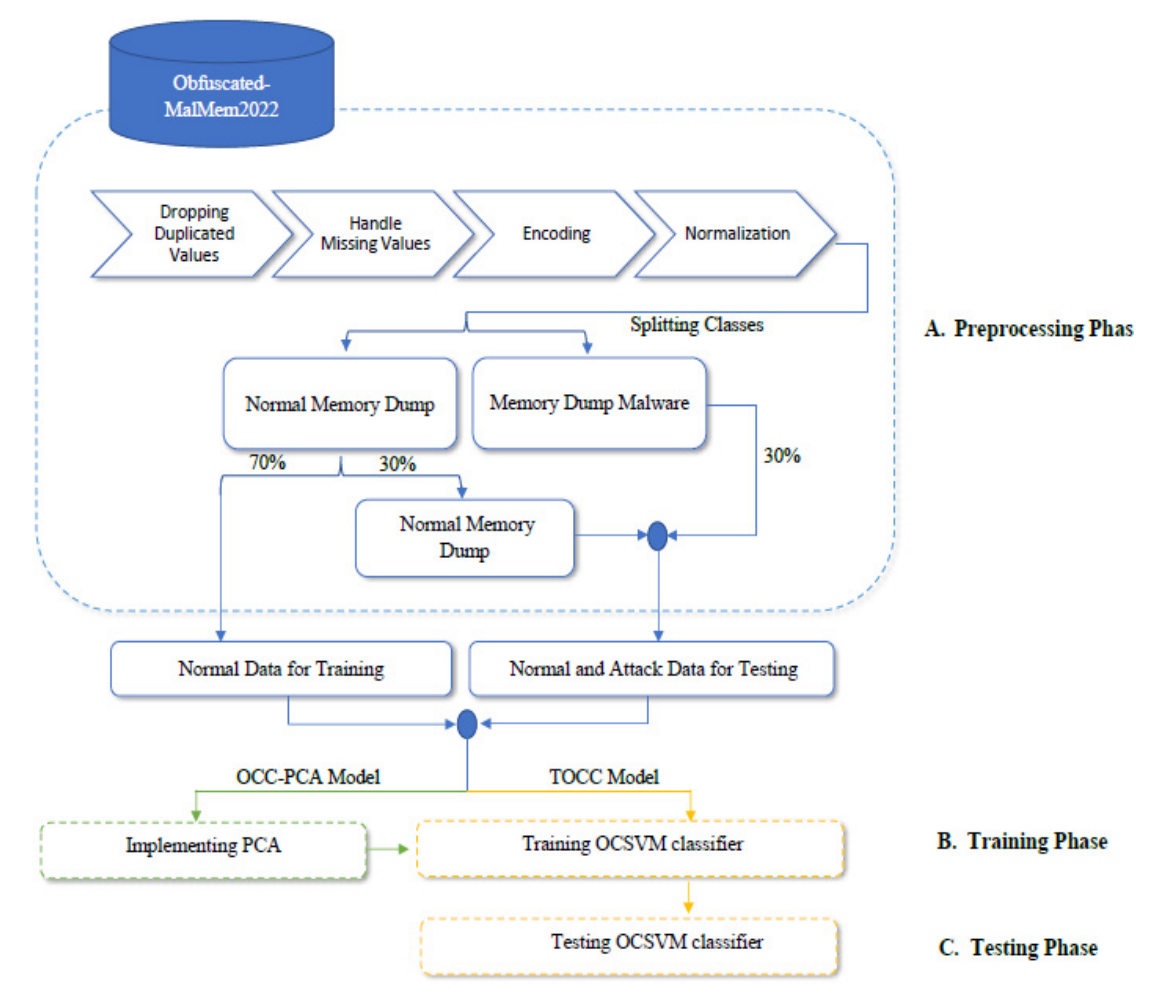
Figure 3. The Methodology of the Proposed